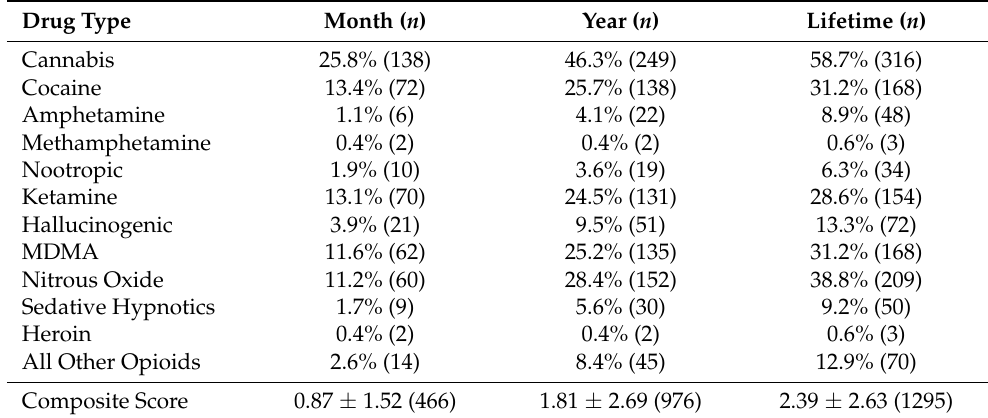
Table 1. Percentage frequencies and composite scores (mean ± standard deviation) for lifetime, past year, and past month prevalence of drug